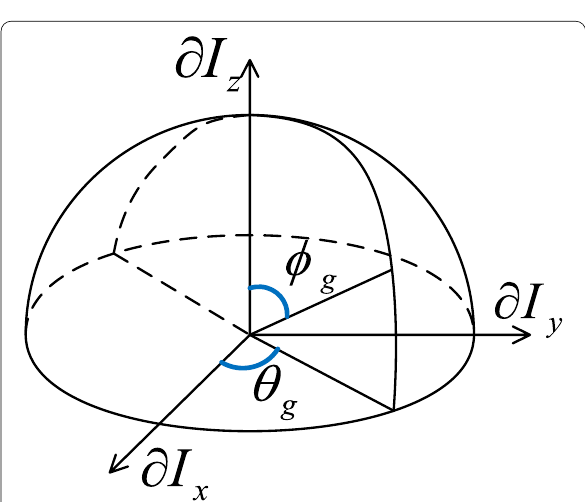
Fig. 2 Diagram showing the azimuth and polar angles θ g and φ g respectively from a vector � I